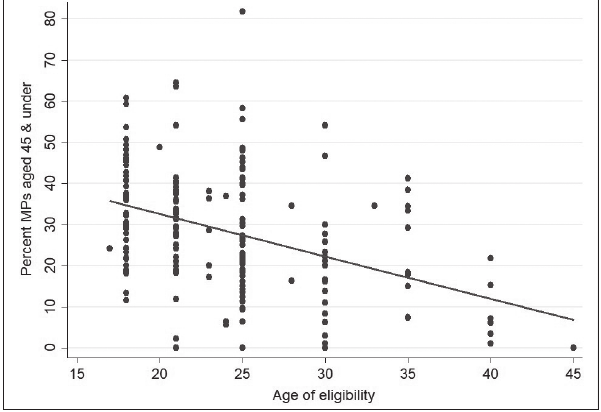
Figure 5: Share of MPs by age eligibility